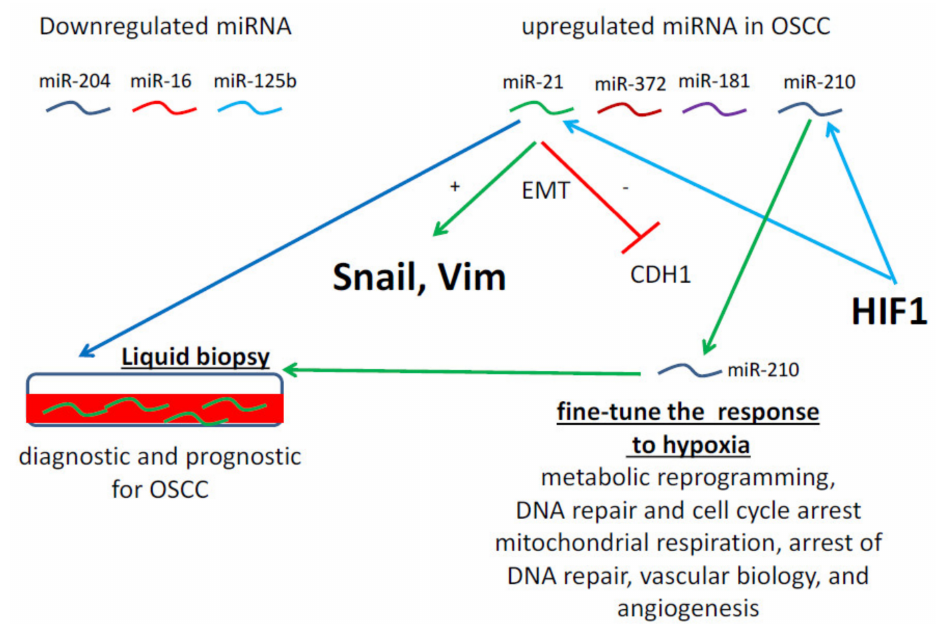
Figure 3. Deregulated miRNAs in OSCC. Some representative deregulated miRNAs in OSCC are given, which are hypoxia / HIF1-regulated or involved in EMT. The use of miRNAs present in liquid biopsies might be used as diagnostic or prognostic markers in